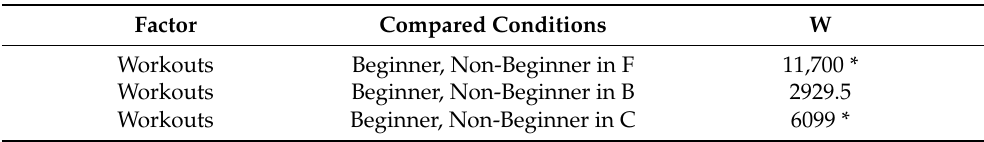
Table 9. Post-hoc Mann–Whitney tests results for the variable “Workouts” conducted on the sub- samples of beginners and non-beginners. Factor Compared Conditions W Workouts Beginner, Non-Beginner in F 11,700 * Workouts Beginner, Non-Beginner in B 2929.5 Workouts Beginner, Non-Beginner in C 6099 *